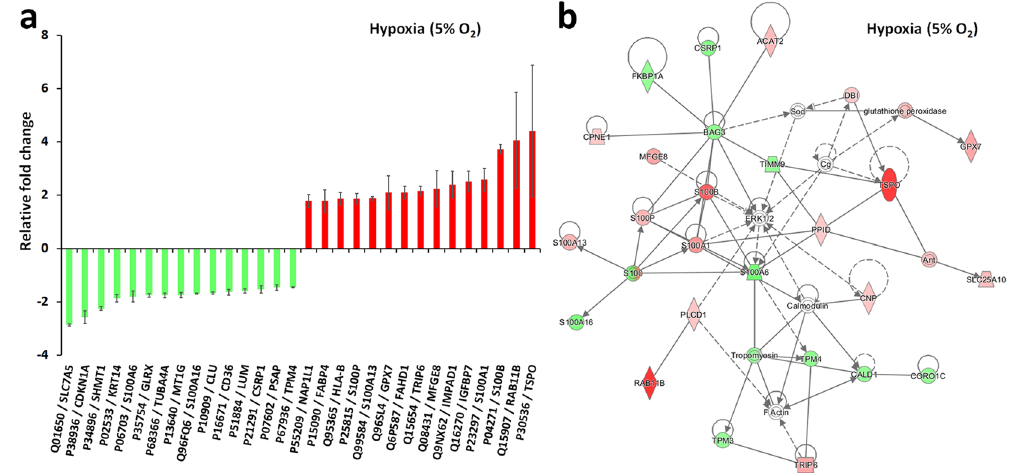
Figure 3. The fifteen most up-regulated and down-regulated proteins produced by a 28-day exposure to 10 µ M Y-27632 at 5% oxygen atmosphere ( a ). An IPA ® protein pathway analysis suggested a molecular network with the highest number of focus molecules (focus molecules 26, score 59) ( b ). The network was connected to both molecular transport and to cell death and survival. The IPA ® analysis was not able to interpret at the network level an increase in extracellular matrix production. An additional secretome analysis could improve the power of the pathway analysis in the context of an extracellular matrix study. Error bars indicate 95% confidence intervals ( n = 3).